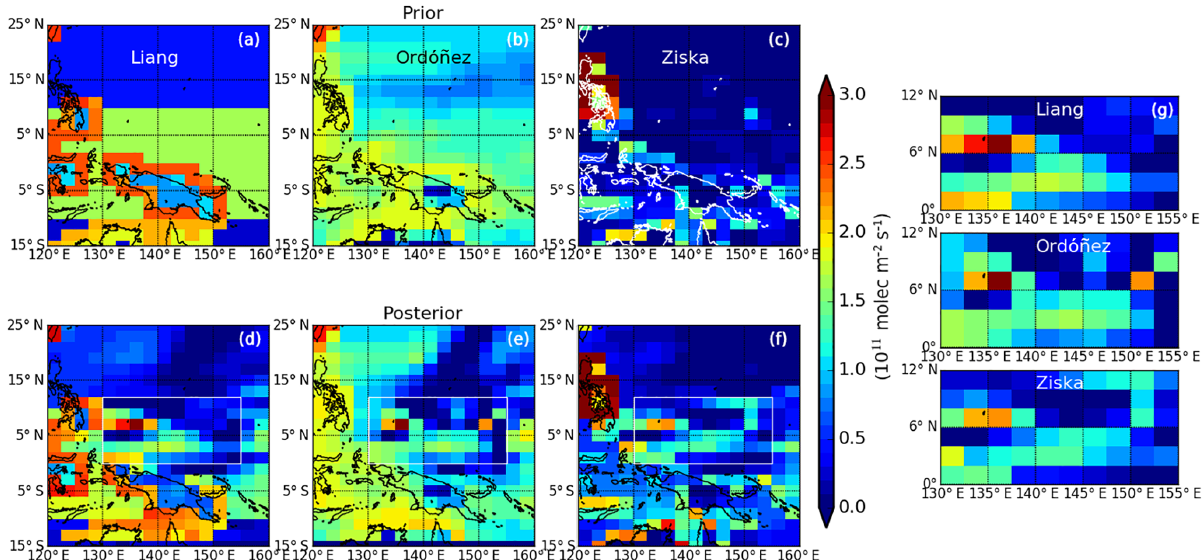
Figure 6. A priori (a) and a posteriori (d) CHBr 3 flux estimates (10 11 molm − 2 s − 1 ) over the study region. The three a priori inventories include Liang et al. (2010), Ordóñez et al. (2012), and. Ziska et al. (2013). The right panel is focused on the geographical region 130–155 ◦ E and 0–12 ◦ N, where CAST and CONTRAST data density was